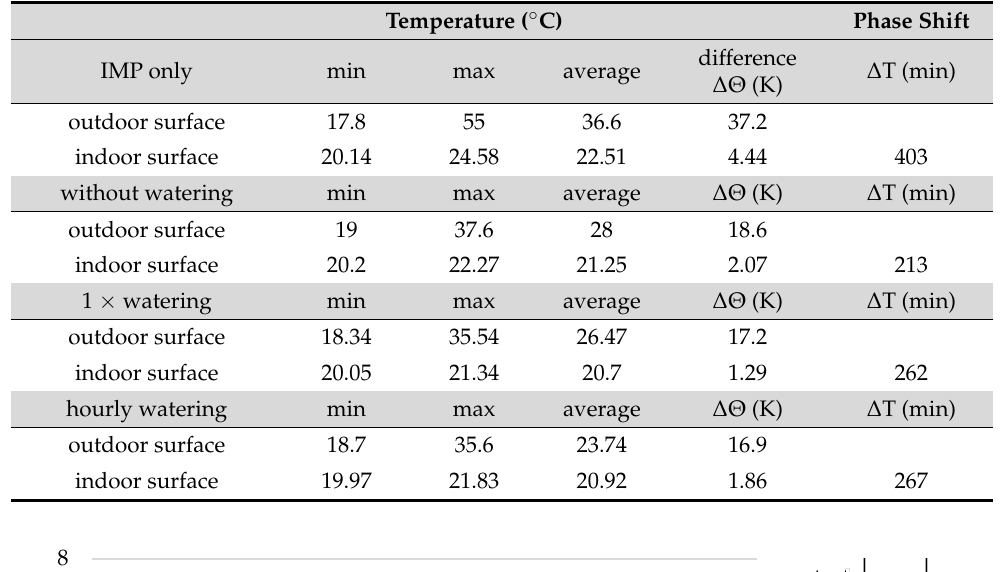
Table 1. Outdoor (S2) and indoor surface (S3) temperatures for simulated regimes. Phase shift is time difference between the surface temperature peaks (maximum values).